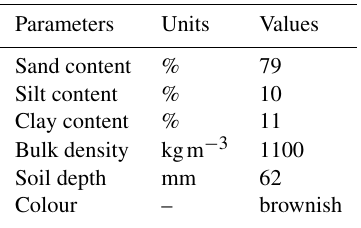
Table 2. Main physical characteristics of the soil used in the soil flume experiments (de Lima et al.,